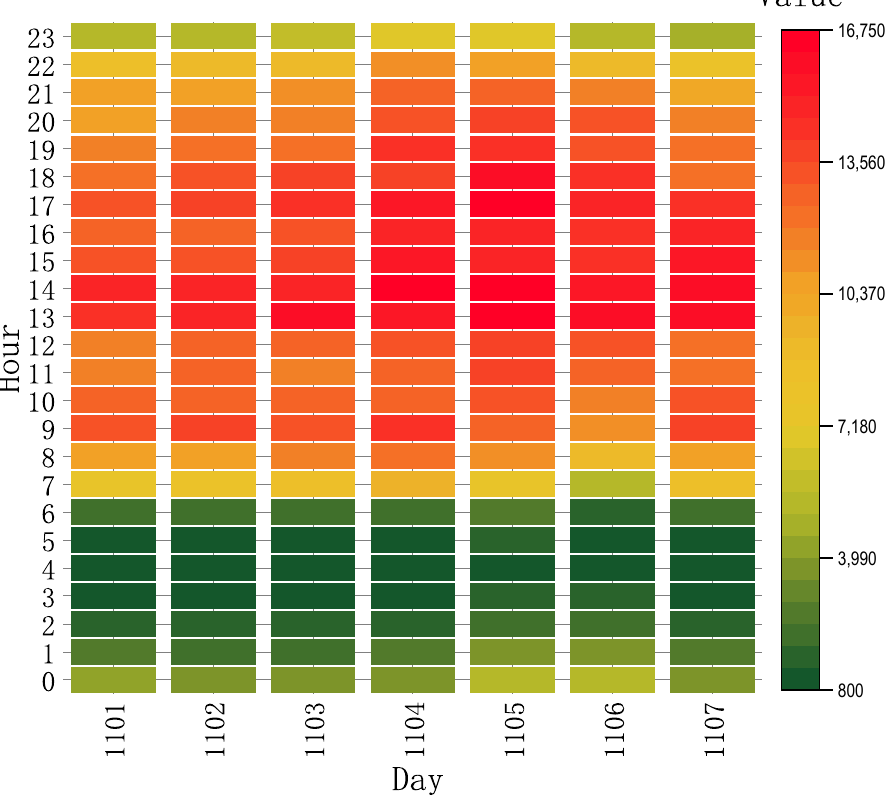
Figure 4. Thermogram of taxi